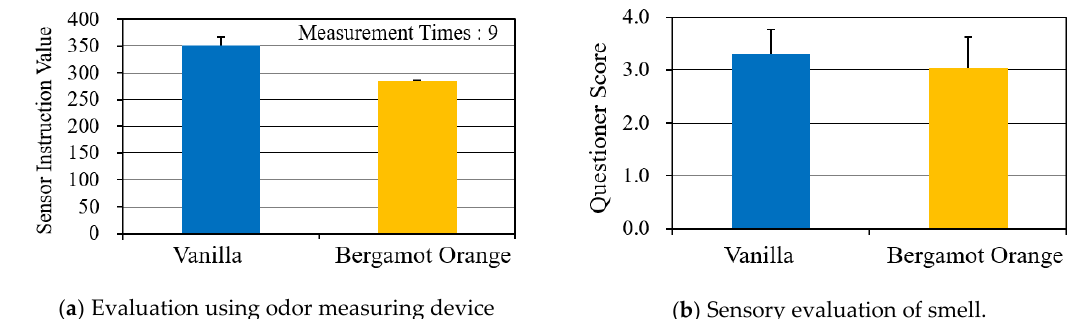
Figure 2. Strength of presented smell.